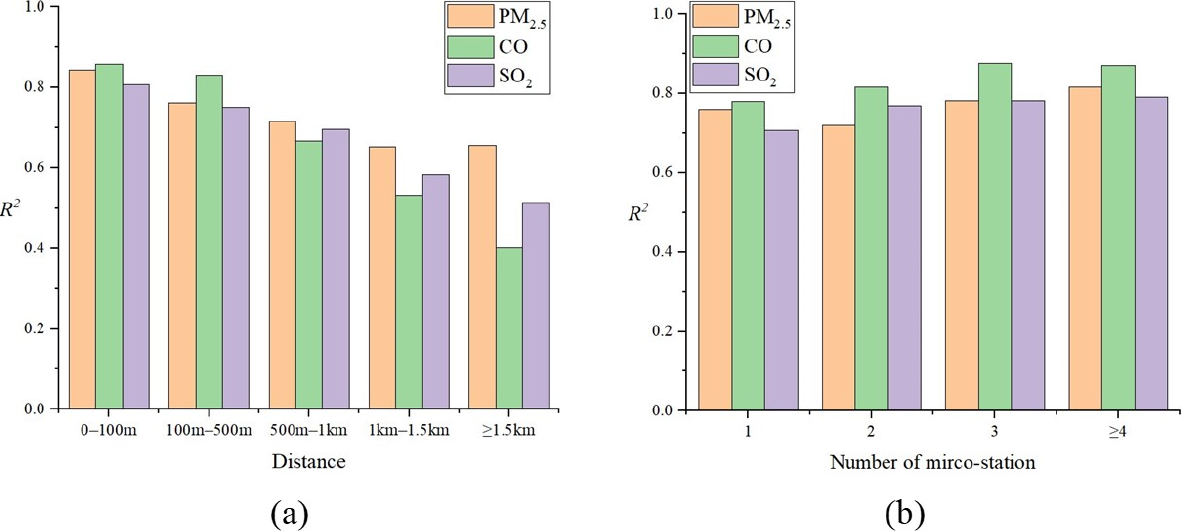
Figure 4. The impact of dense monitoring data on model performance: ( a ) by different distances between each grid and its nearest micro stations; ( b ) by different numbers of micro station.